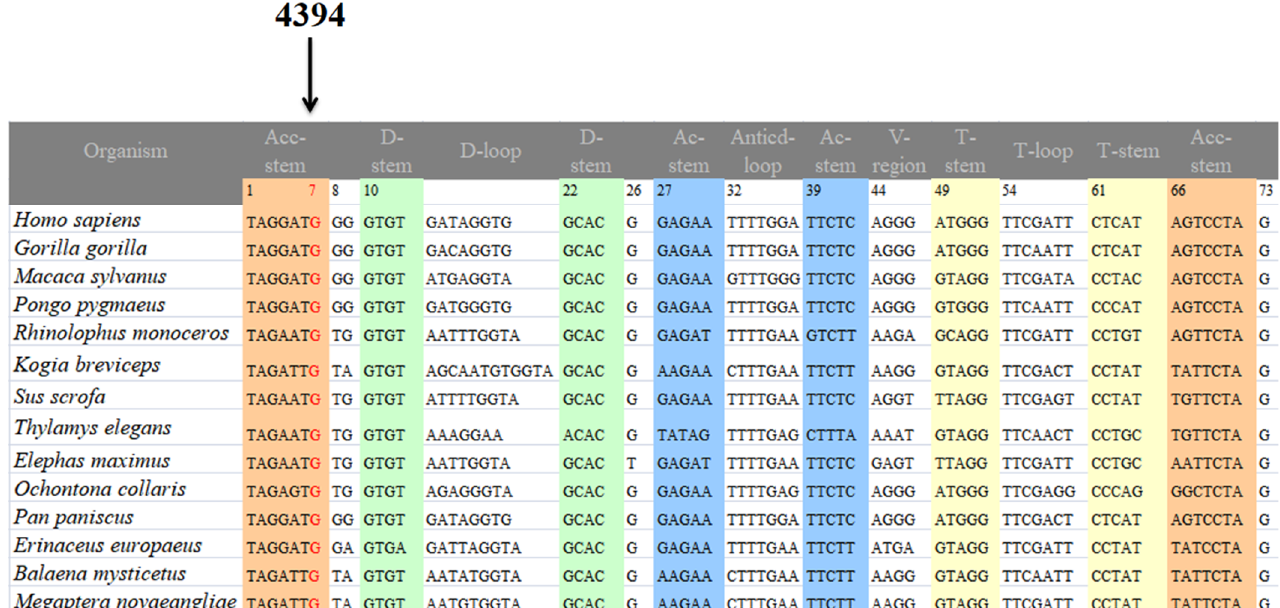
Figure 5. Sequence alignment of the mt-tRNA Gln gene from 14 species. The arrow indicates the m.4394C>T mutation.